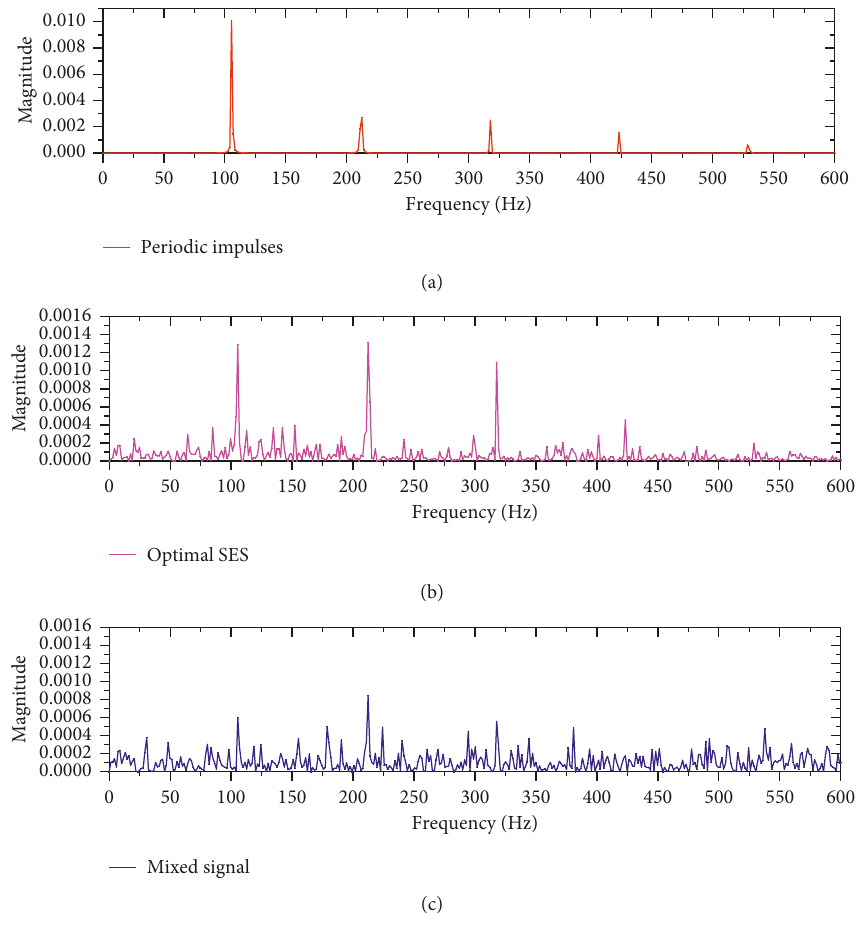
Figure 4: The results of mixed signal processed by